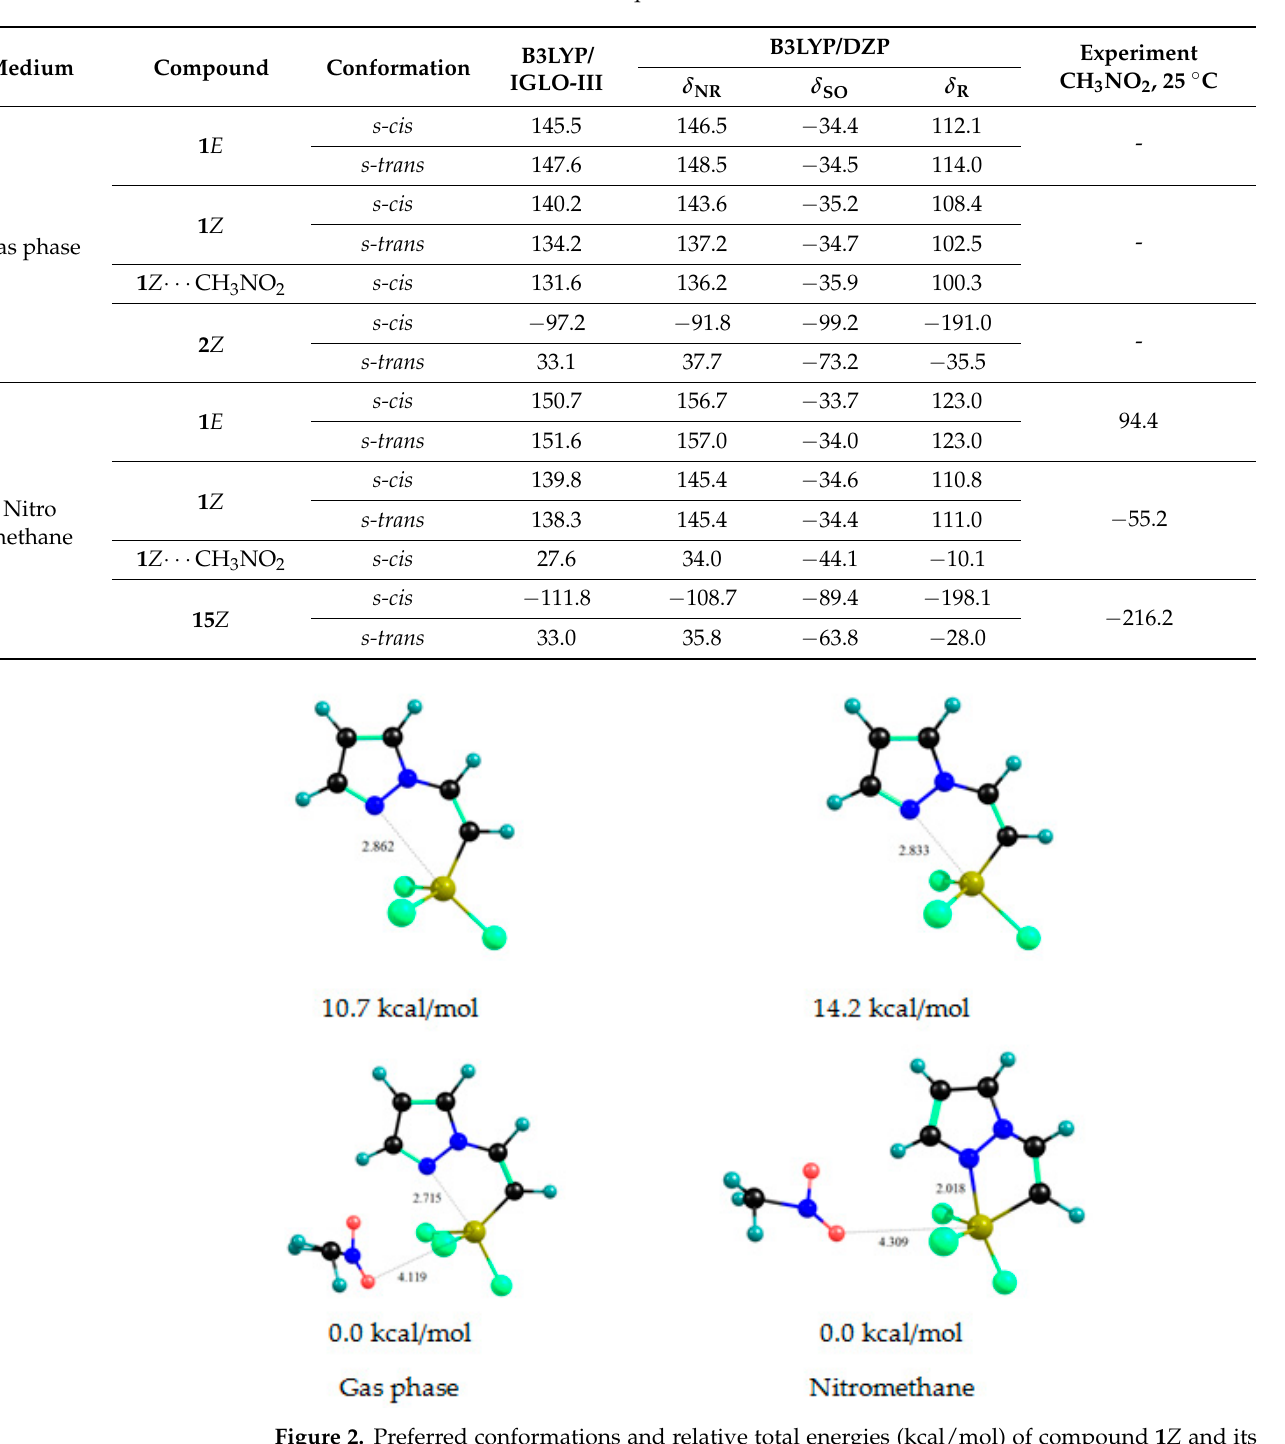
Table 7. The 31 P NMR chemical shifts of compounds 1 and 15 (ppm) calculated with both nonrela- tivistic GIAO-B3LYP/IGLO-III and quasi-relativistic ZORA-GIAO-B3LYP/DZP levels.